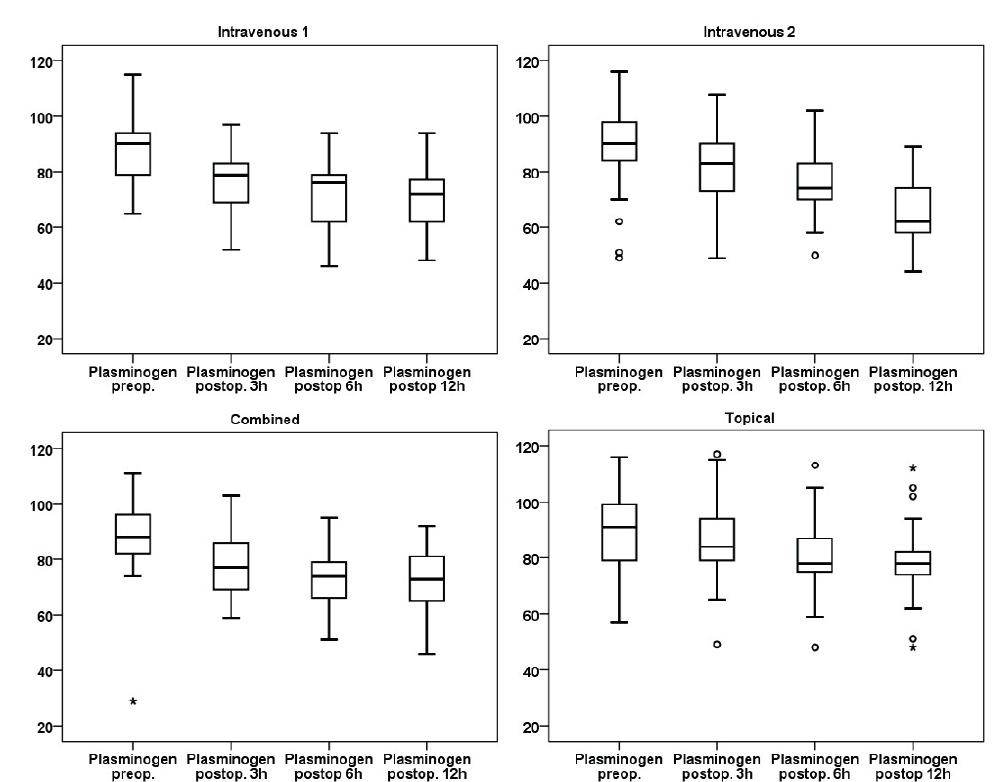
Fig. 3. Comparison of postoperative level of plasminogen at 3, 6, and 12 h after the start of the surgery.